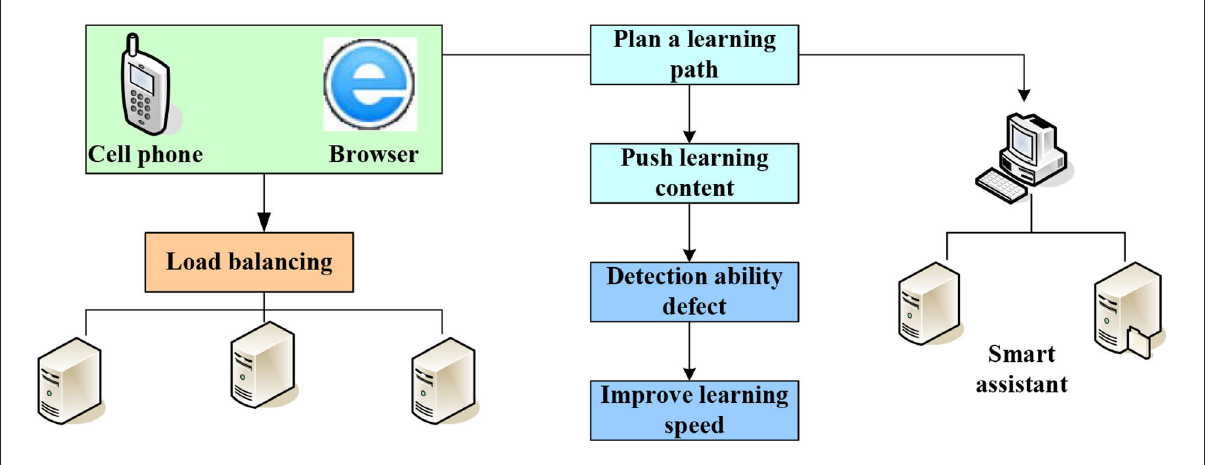
FIGURE1 Artificial intelligence